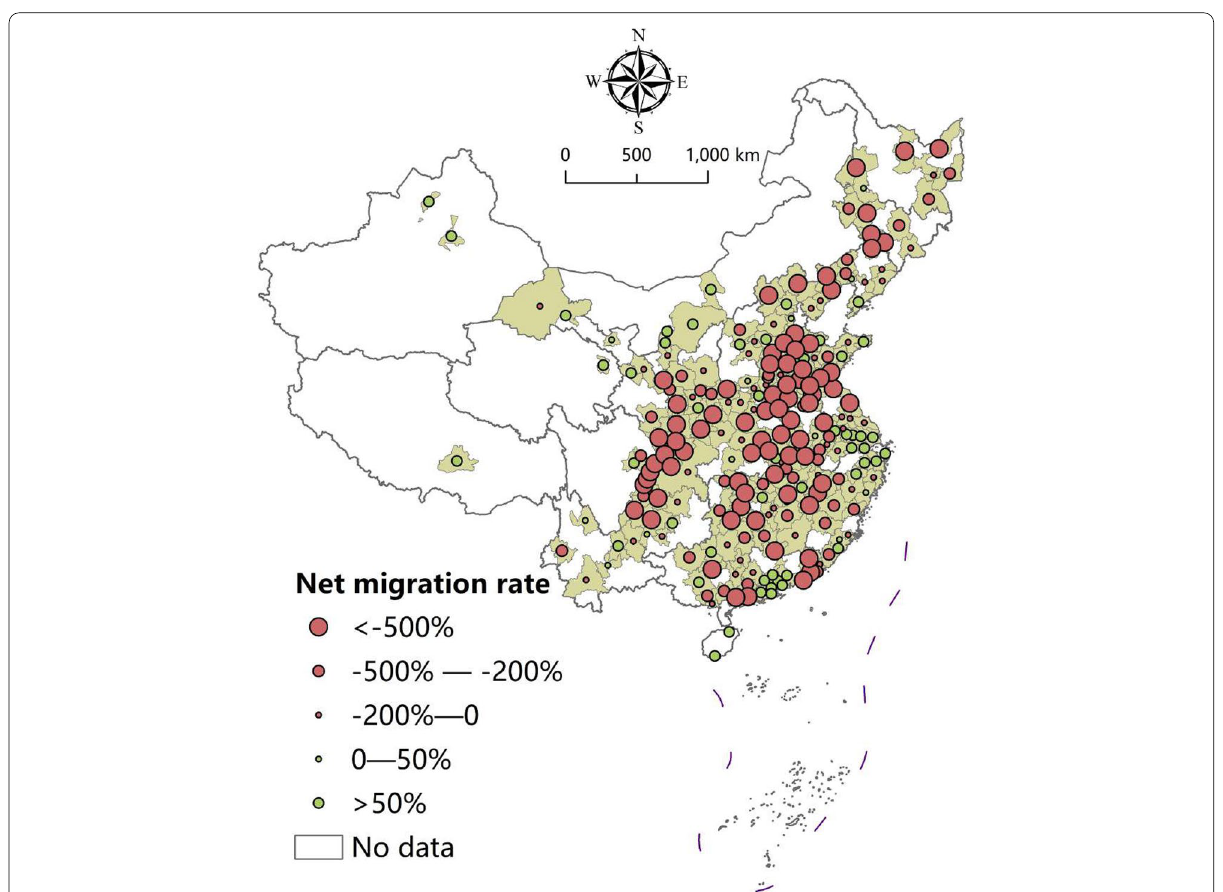
Fig. 3 Spatial pattern of net migration rate. Data source: China Migrants Dynamic Survey (CMDS;